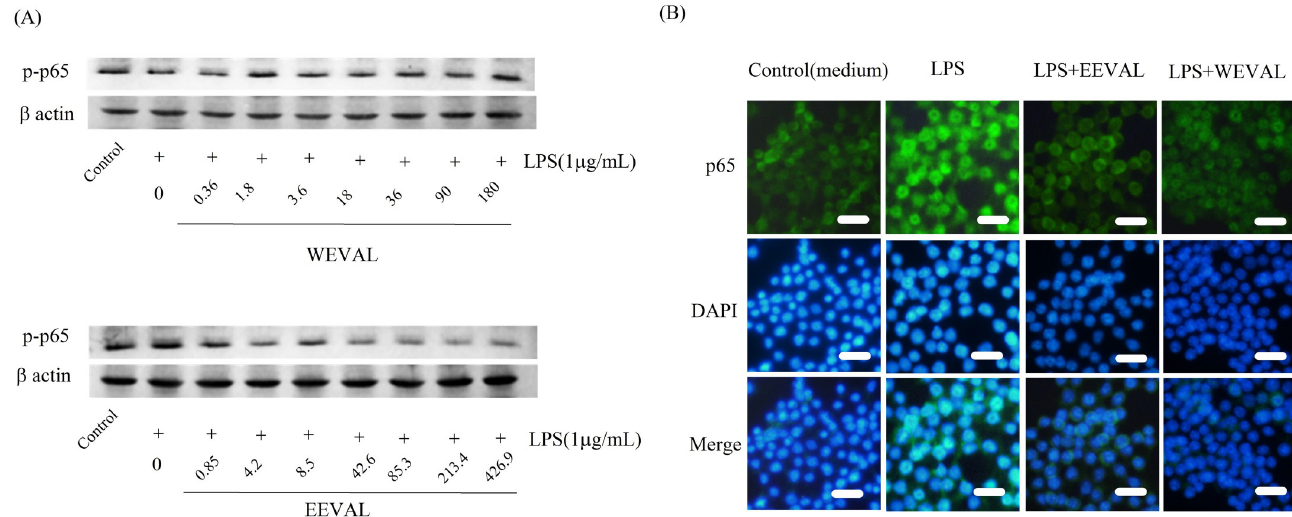
Fig 5. NF-B p65 nuclear translocation in LPS-stimulated RAW 264.7 macrophages. (A) Effect of WEVAL and EEVAL on expression of phospho-NF- κ B p65 was measured by western blot analysis. (B) Effect of WEVAL and EEVAL on NF-B p65 protein translocation from cytosol to nucleus in macrophages. Nuclei were stained by DAPI. p65 expression was analyzed by immunofluorescence